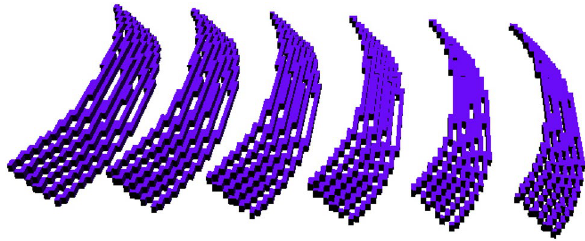
Fig. 5 The lateral accretion model of point bar